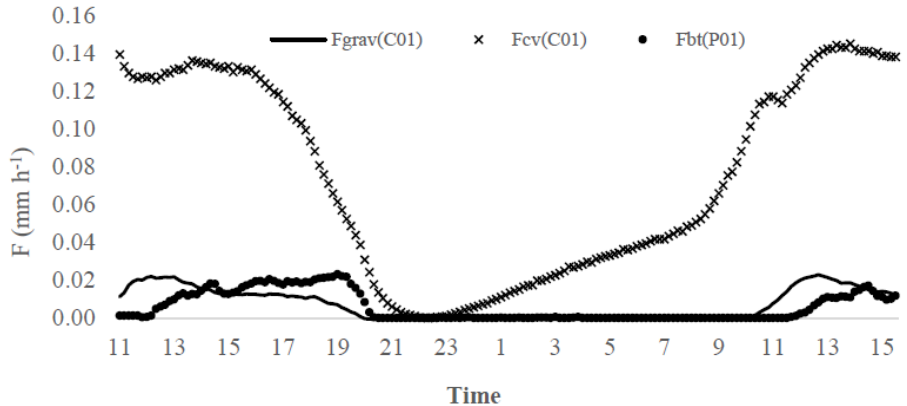
Figure 8. Sap flow measured in potted olive tree (P01) and computed with the Biot-Granier approach (F bt(P01) , mm h −1 ), and the sap flow observed for gravimetric test (F grav(C01) , mm h −1 ) in potted olive tree (C01) and computed for conventional Granier approach (F cv(C01) , mm h −1 ) in days 17–18 April 2018 (Experiment I).